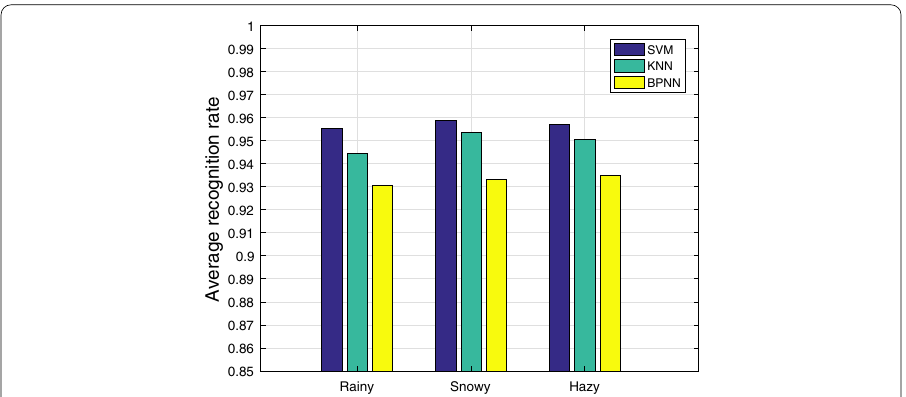
Fig. 12 Stability of DFA algorithm by cross-validation (Sunny data set as training